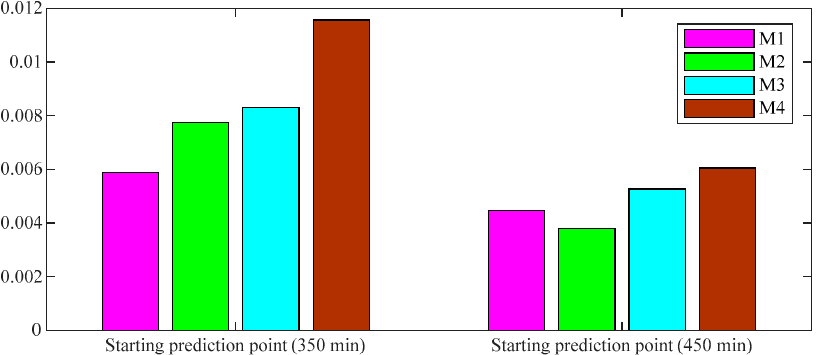
Figure 16. Different prediction starting points (350 min and 450 min) under the evaluation index (MAPE).